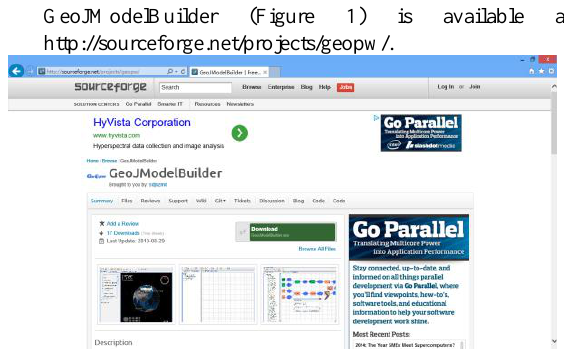
Figure 1. GeoJModelBuilder - an open source modelling tool.